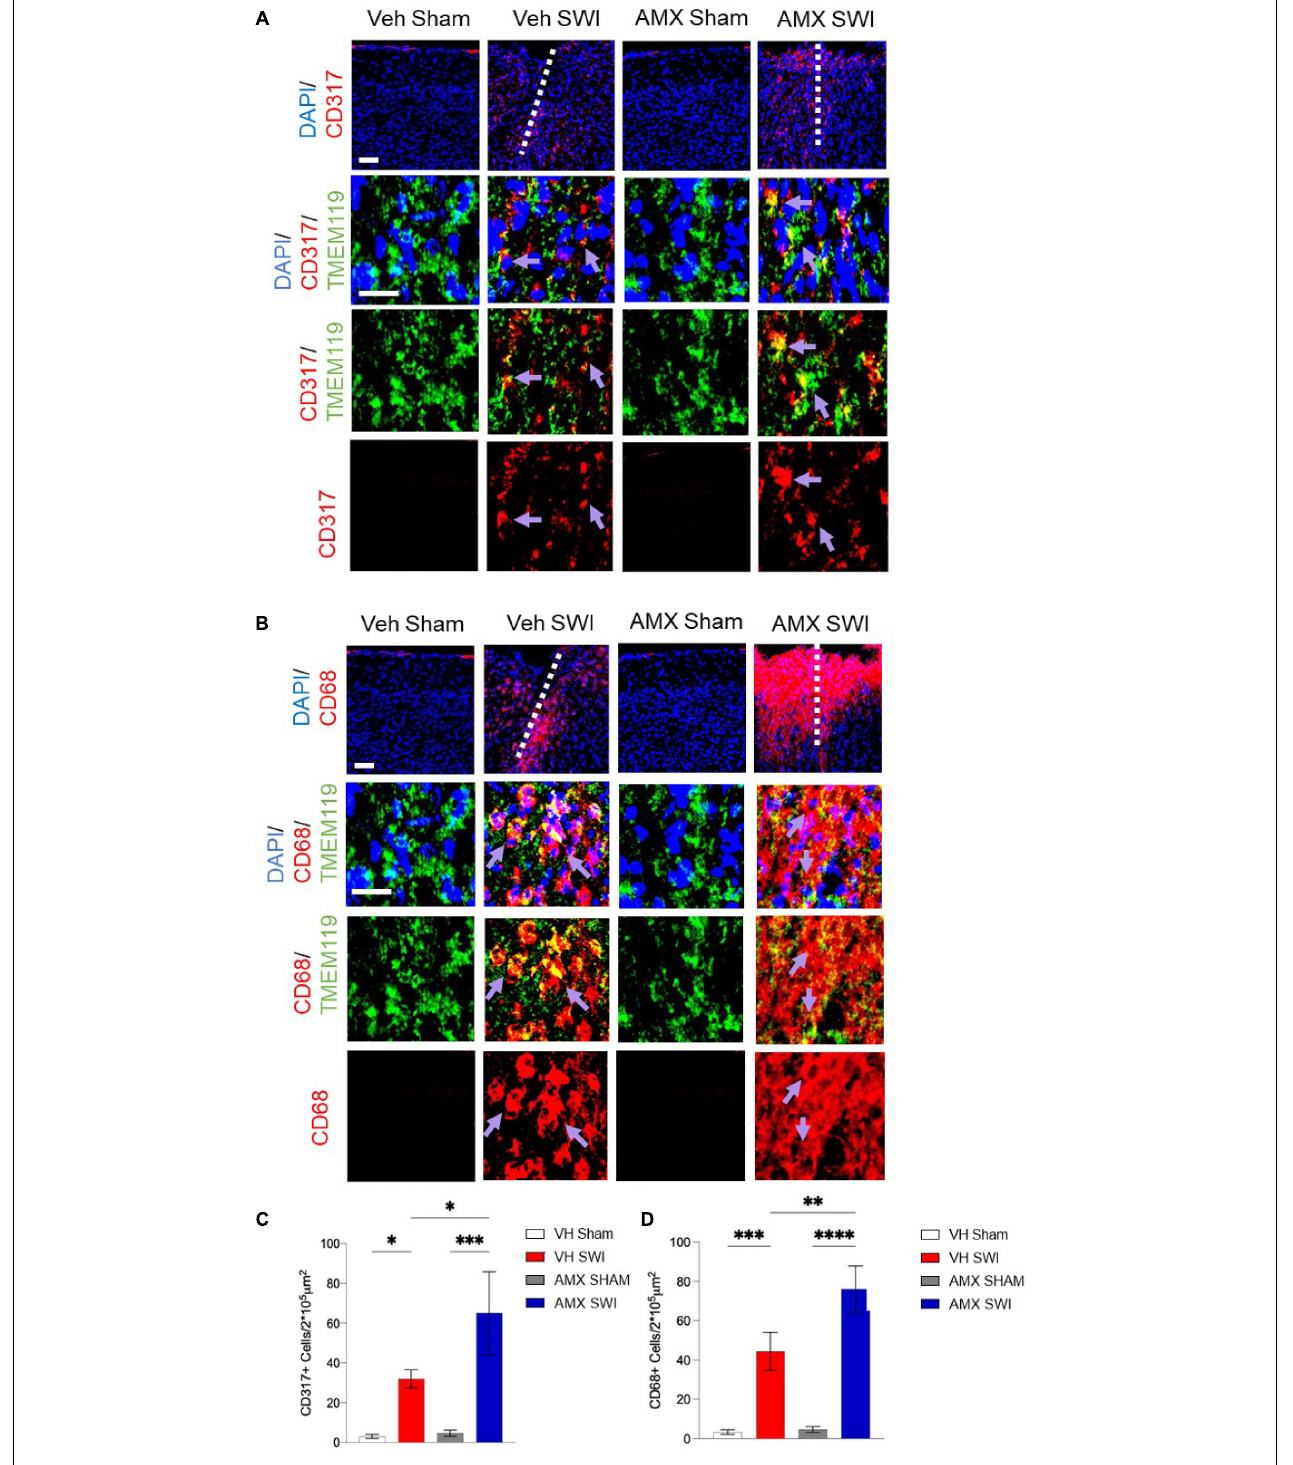
FIGURE 3 | Tbk1 blockade enhances the induction of CD317 + interferon-stimulated microglia and CD68 + phagocytic microglia. (A,C) AMX treatment substantially increased the number of microglia TMEM119 + that expressed the interferon-induced CD317 marker upon SWI (at 7 dpi). (B,D) AMX upregulated the expression of the phagocytosis marker CD68 in TMEM119 + microglia upon SWI. ( n = 3 animals/group with 4 sections/animal. Average ± SD; two-way ANOVA with Tukey’s post hoc ; ∗ p < 0.05, ∗∗ p < 0.01 ∗∗∗ p < 0.001, ∗∗∗∗ P < 0.0001; full statistical report in Supplementary Table 5 ). Upper panel, low magnification; lower panels, insets at high magnification. Scale bars (equal for both sets of panels) 200 µ